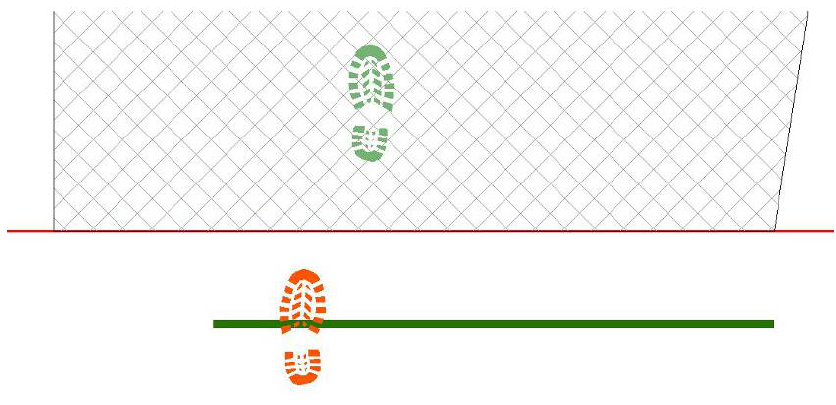
Figure 15. Software workflow, step